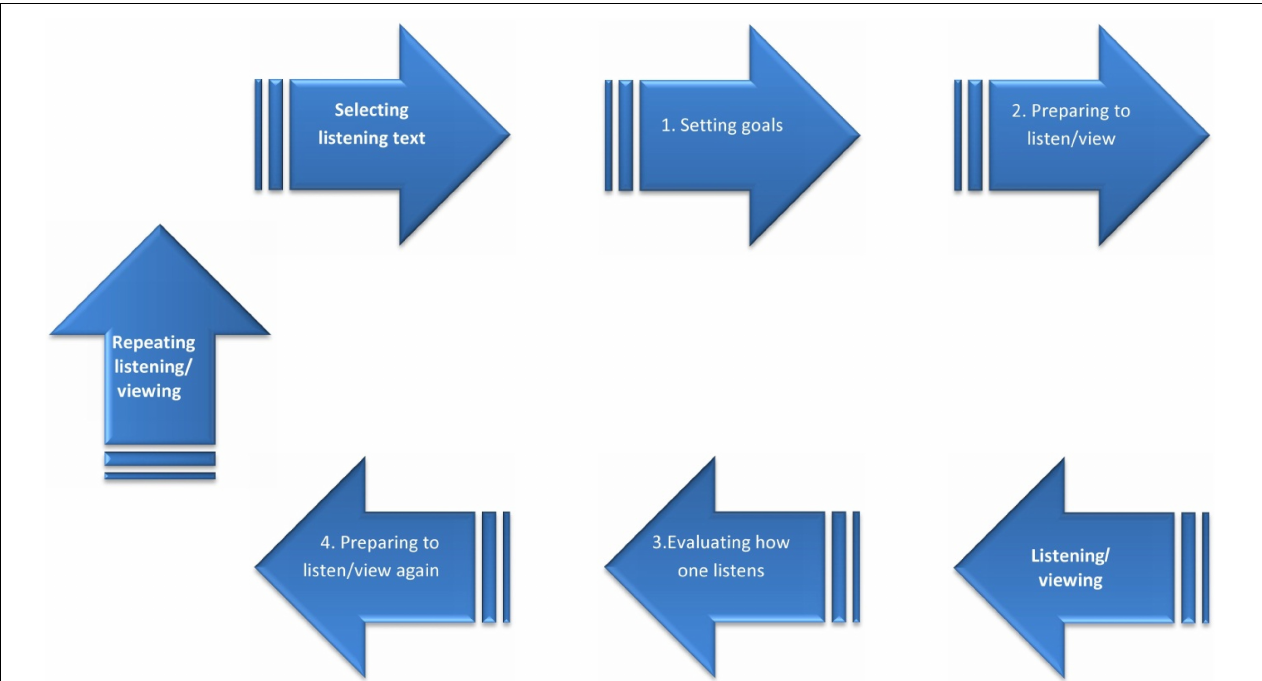
FIGURE 1 | Four types of prompts for self-directed listening/viewing (Vandergrift and Goh, 2012, p.